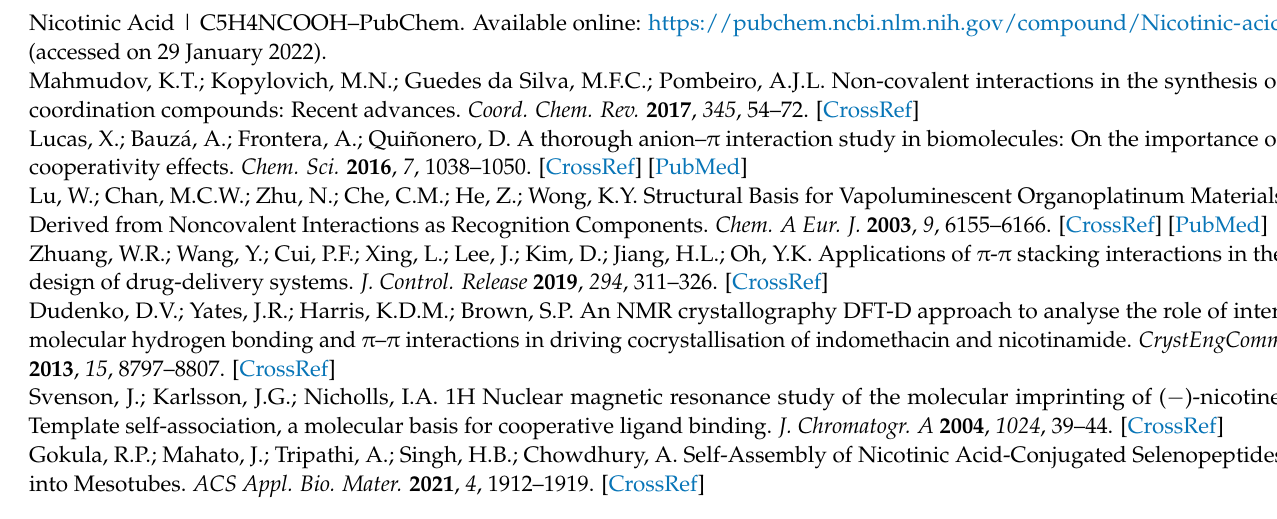
K. Figure S2. The 2D fingerprint plots of interatomic interactions for cation in I at 100 K show the percentages of contacts contributed to the total Hirshfeld surface area of the molecules. Figure S3. The 2D fingerprint plots of interatomic interactions for cation in II at 100 K show the percentages of contacts contributed to the total Hirshfeld surface area of the molecules. Figure S4. The 2D fingerprint plots of interatomic interactions for cation in III at 100 K show the percentages of contacts contributed to the total Hirshfeld surface area of the molecules. Figure S5. The 2D fingerprint plots of interatomic interactions for anion in I at 100 K show the percentages of contacts contributed to the total Hirshfeld surface area of the molecules. Figure S6. The 2D fingerprint plots of interatomic interactions for anion in II at 100 K show the percentages of contacts contributed to the total Hirshfeld surface area of the molecules. Figure S7. The 2D fingerprint plots of interatomic interactions for anion in III at 100 K show the percentages of contacts contributed to the total Hirshfeld surface area of the molecules. Table S1. Bond lengths for I at 100 K. Table S2. Bond angles for I at 100 K. Table S3. Torsion angles for I at 100 K. Table S4. Bond lengths for I at 296 K. Table S5. Bond angles for I at 296 K. Table S6. Hydrogen bonds for I at 296 K. Table S7. Torsion angles for I at 296 K. Table S8. Bond lengths for II at 100 K. Table S9. Bond angles for II at 100 K. Table S10. Torsion angles for II at 100